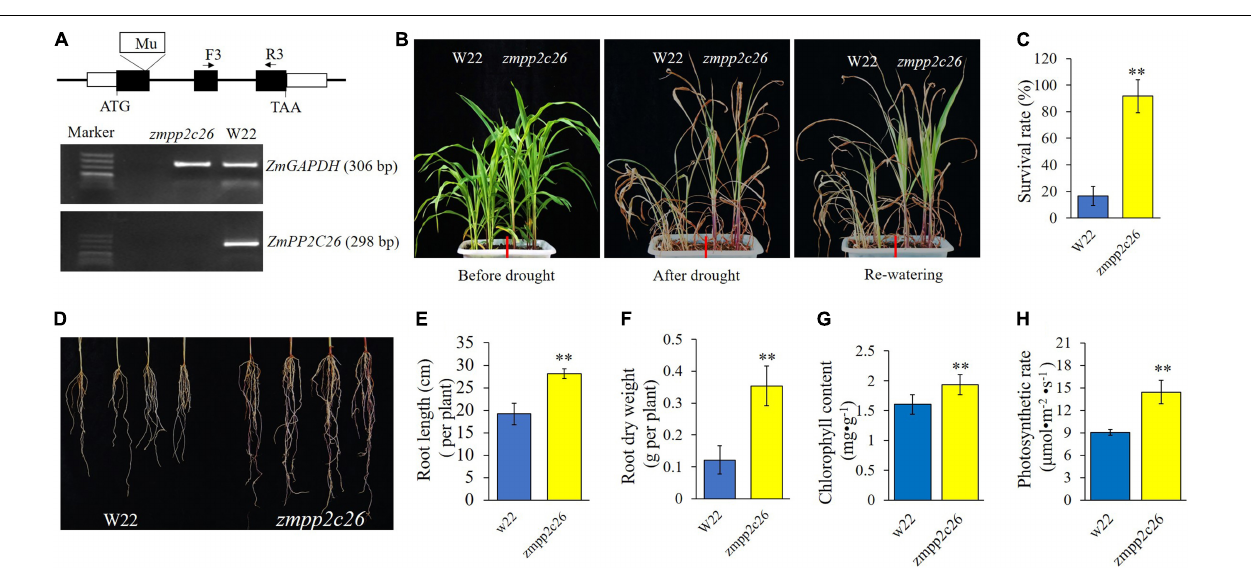
FIGURE 6 | Phenotyping of maize zmpp2c26 under drought stress. (A) Schematic diagram of Mu transposon in ZmPP2C26 gene and transcriptional detection ZmPP2C26 by RT-PCR. Black boxes represent exons; F and R, primer position in ZmPP2C26, and the sequences of them were listed in Supplementary Table 1 . A 298 bp fragment of ZmPP2C26 was amplified from zmpp2c26 cDNA using F and R primers. A 306 bp fragment of ZmGAPDH was amplified and used as reference. W22, the wild type isolated from heterozygous zmpp2c26 mutant, was used as control. (B) Wilting phenotype of every line. The three-leaf stage seedlings were subjected to drought stress via withholding watering for 3 weeks, then re-watered for 5 days and photographed. (C) The survival rate of every line after treatment. (D) Root phenotype of every line. (E,F) Root length and root dry weight of every line. (G,H) Chlorophyll content and photosynthetic rate of every line before treatment. ∗∗ P <